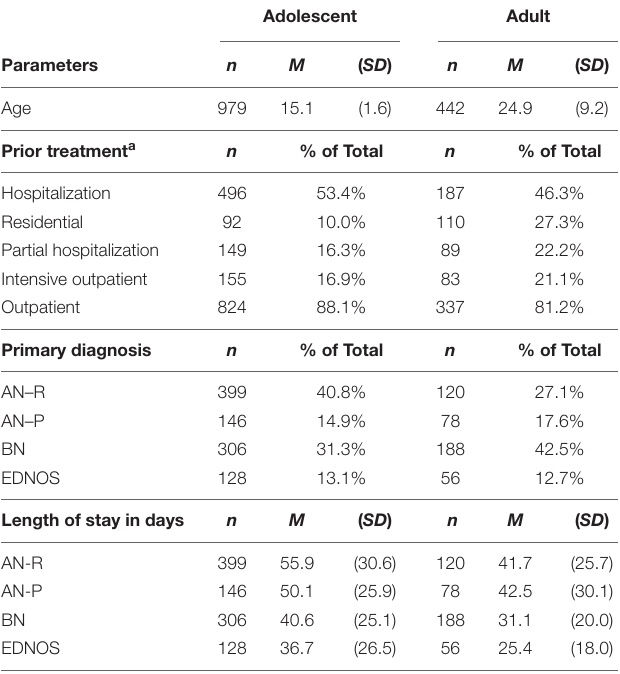
TABLE 2 | Status on admission and discharge of adolescent ED residential patients by diagnosis.